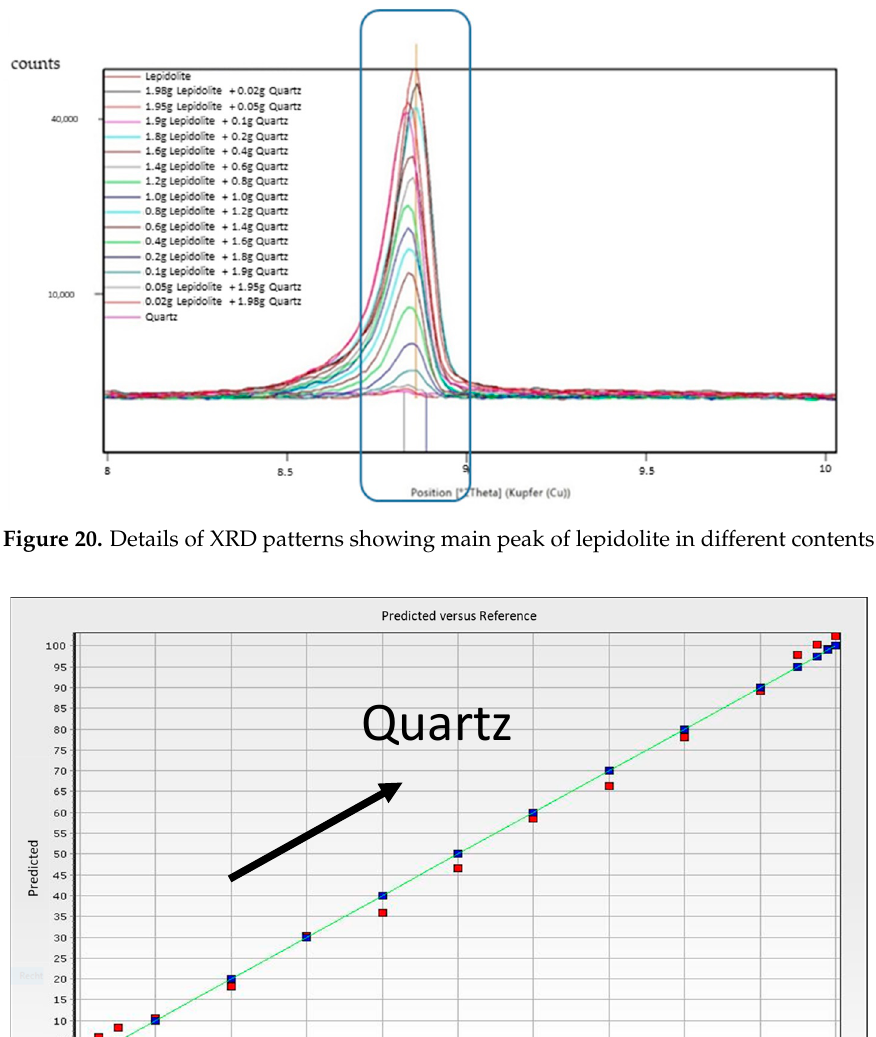
Figure 19. XRD patterns of quartz–montebrasite mixtures forming the four relevant calculated clusters.